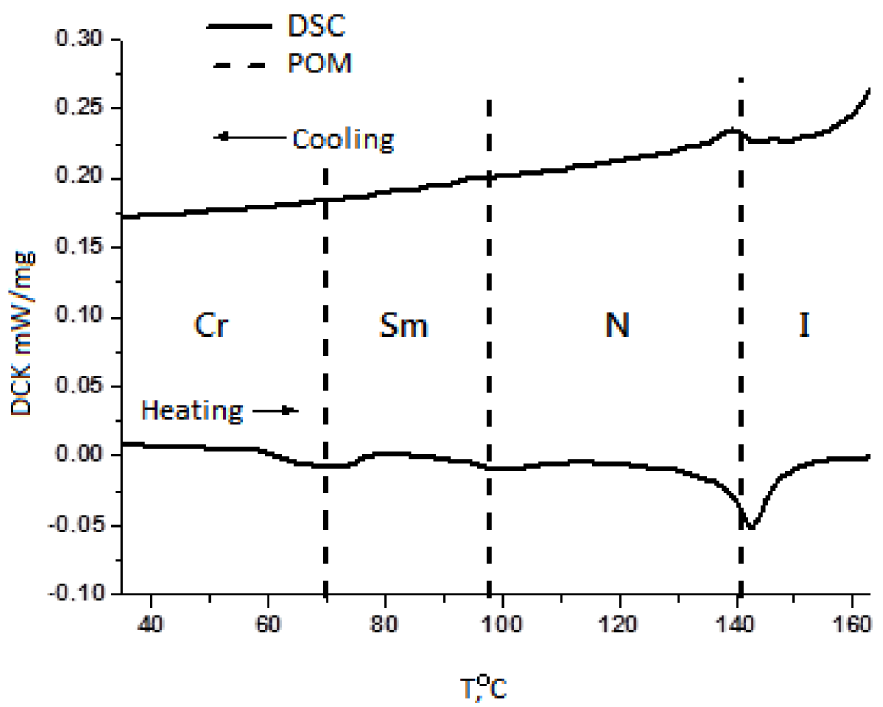
Figure 3. Differential scanning calorimetry (DSC) thermogram of the gadolinium complex Gd(CPDk 3 − 5 ) 3 Bpy at a heating and cooling rate of 10 ◦ C/min 17 − 17